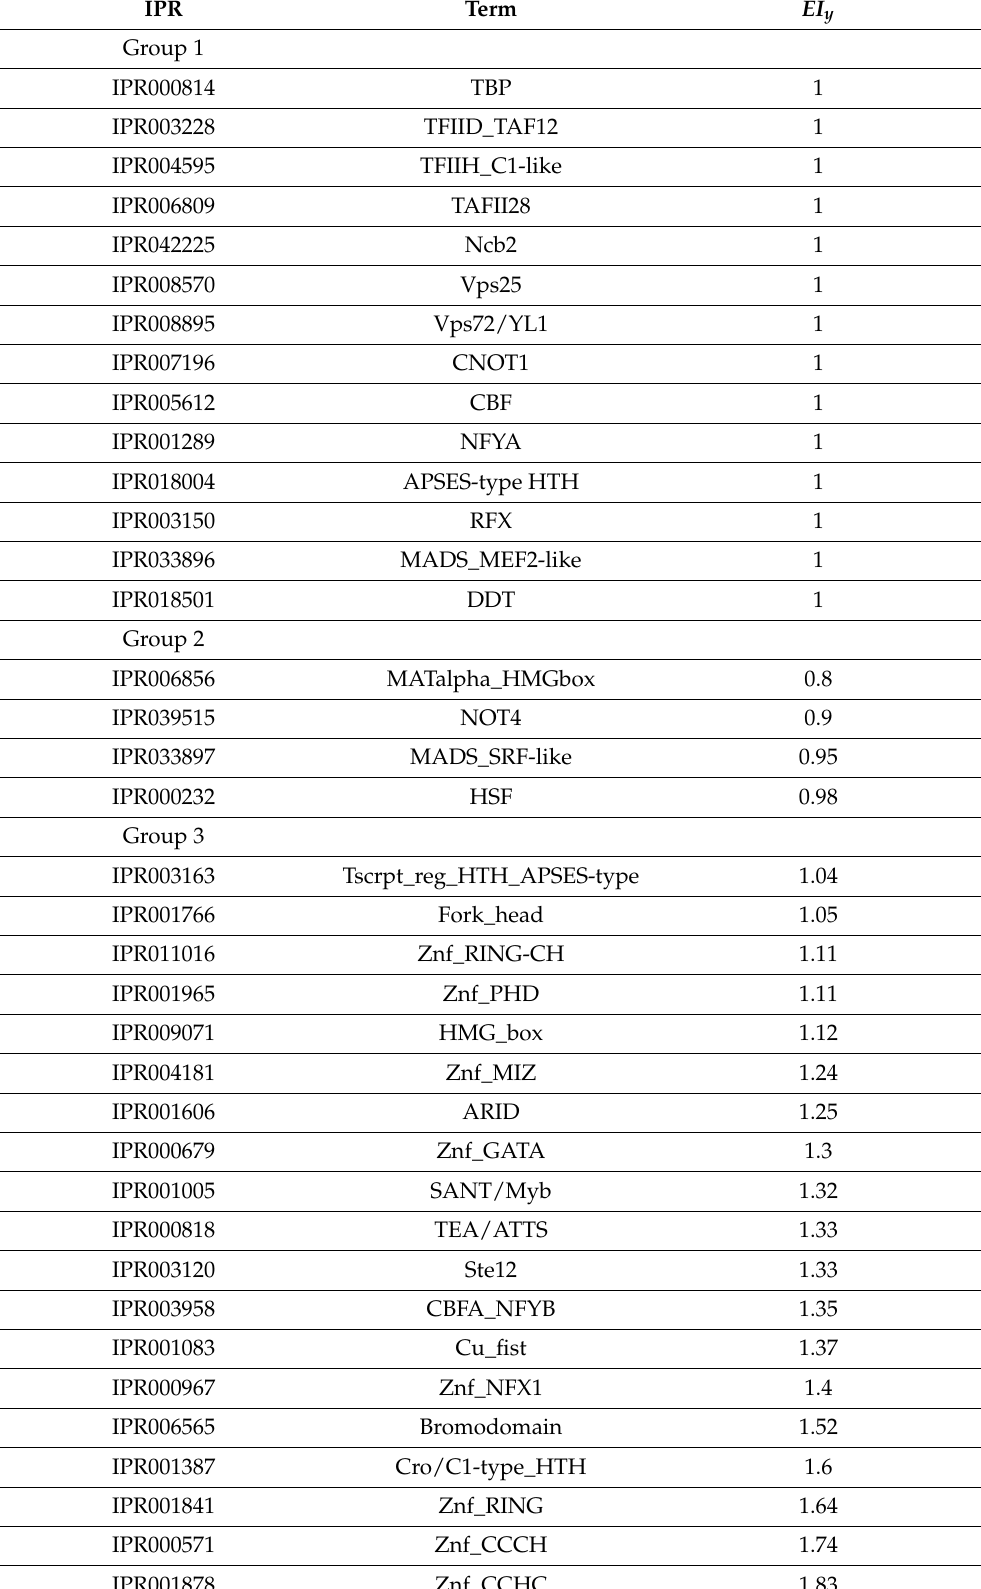
Table 2. Expansion index ( EI y ) of 48 TF